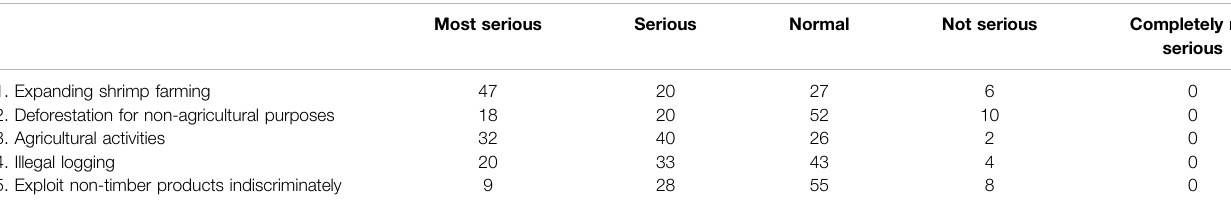
TABLE 4 | Comparing the serious threats of forest degradation (% selected) Most serious Serious Normal Not serious Completely not